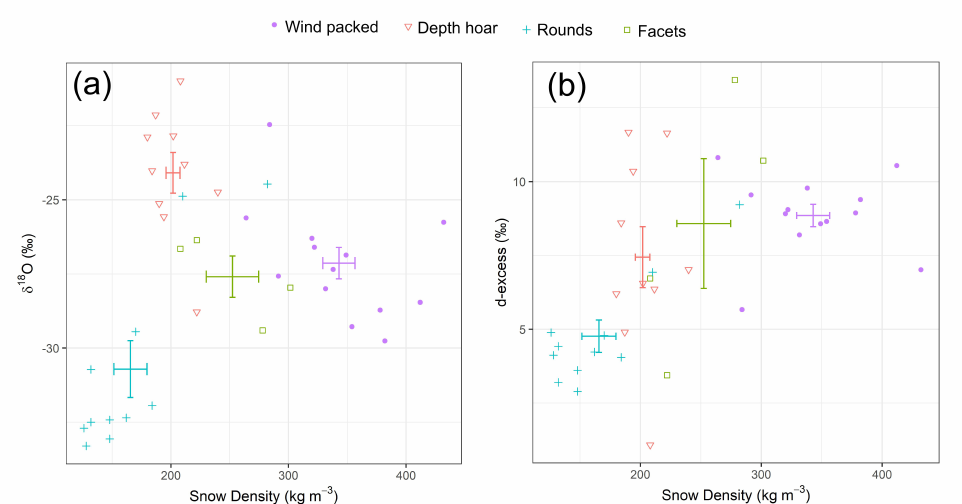
Figure 7. ( a ) δ 18 O and ( b ) d-excess for Imnavait snowpack samples as a function of snow density, grouped by snow grain type. The error bars display the mean, and the standard error of the mean, for each group.Examining snow layer d-excess values as a function of normalized snow depth (Figure 8), in addition to grain type and density (Figure 7b), indicates that at Imnavait there is less consistency in d-excess values at different depths of the snow profile compared to δ 18 O (Figure 8a). Only the top layer in the snowpack shows consistent d-excess values. However, when the data are grouped by grain type and plotted in density– d-excess space (Figure 7b), it becomes apparent that the recent storm (rounds) and the high-density wind packed layer are clustered between 3–5‰ and 8–11‰ in d-excess , respectively. To the contrary, the metamorphosed snow layers (depth hoar, facets) are more variable in their d-excess and equally distributed between 0 and 13‰ (Figure 7b). At Pallas, there is higher variability in d-excess values at the base (0–25%) and top (75–100%) of the snow profiles, with d-excess values more uniform in the middle of the snowpack (25–75%). This stratigraphic pattern contrasts with the δ 18 O variability in the profile, where values at the base of the snowpack were the most consistent (Figure